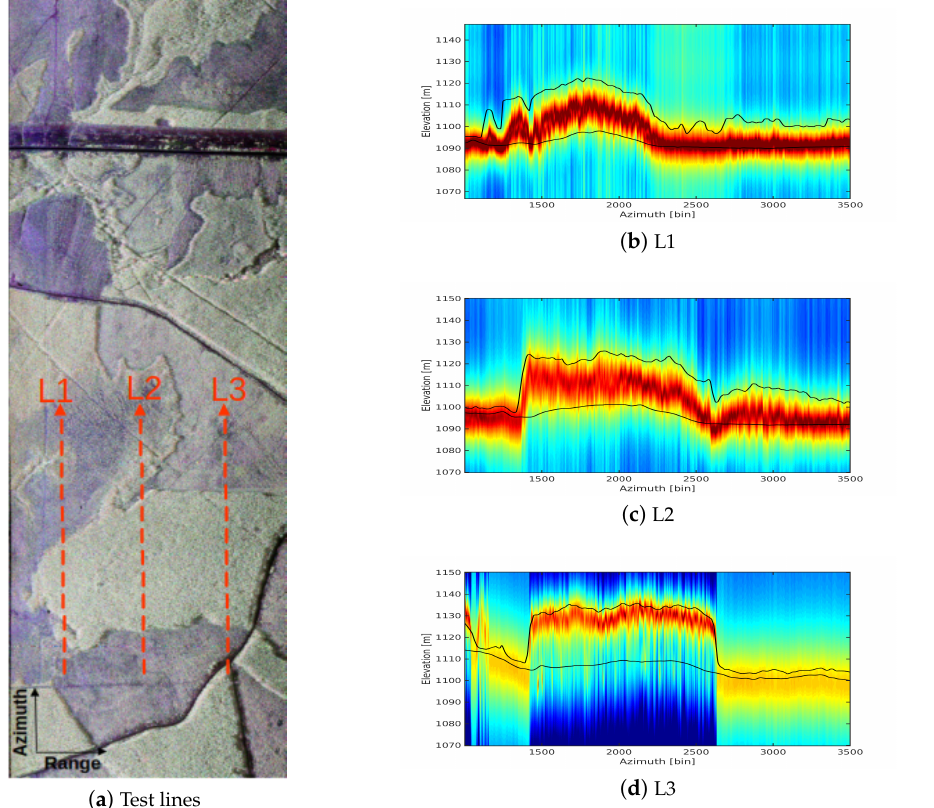
Figure 8. P-MUSIC tomograms for test lines located in near, mid and far range, respectively. n s = 2. The black line is the LiDAR ground and tree top elevation